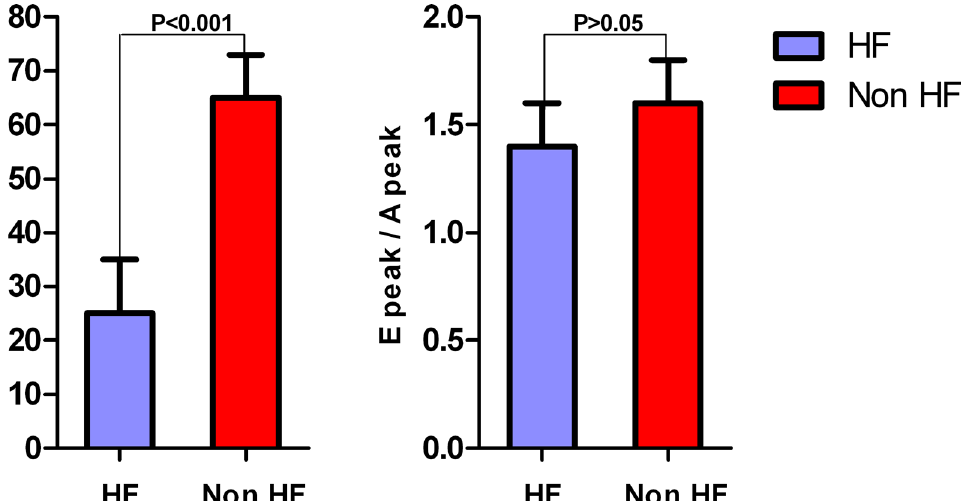
Fig 1. In the heart Doppler examination, the ejection fractions in HF and non-HF patients with sepsis were 25% ± 10.4% and 65% ± 7.5%, respectively, a significant difference ( P < 0.001); the E peak/A peak of the 2 groups were normal and not significantly different (1.4 ± 0.2 cf. 1.6 ± 0.2). The results suggested a left ventricle systolic dysfunction in all heart failure patients with sepsis.